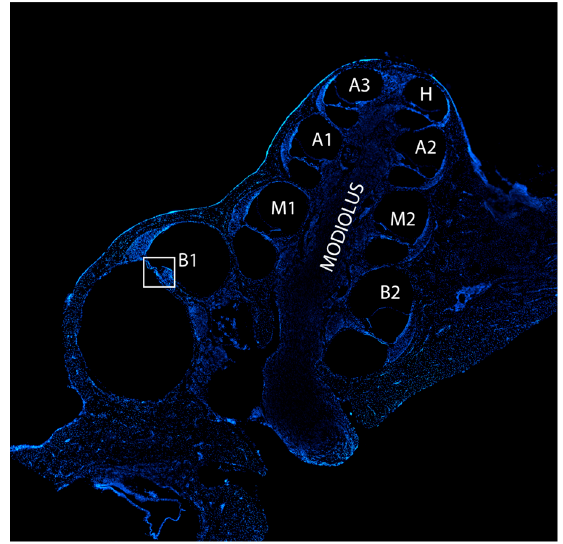
Figure 3. Cochlear cryosection and locations. The image is an overview of a representative midmo- diolar cochlear cryosection stained with bisbenzimide nuclear dye obtained by reconstruction of multiple images with 20x objective. Each cochlear location is labeled with a different lettering: basal semi-turns (B1, B2), middle semi-turns (M1, M2), apical semi-turns (A1, A2, A3) and helicotrema (H). The white frame borders the area of the organ of Corti for B1 and is an example showing the location of the organ of Corti in the cochlear turns.